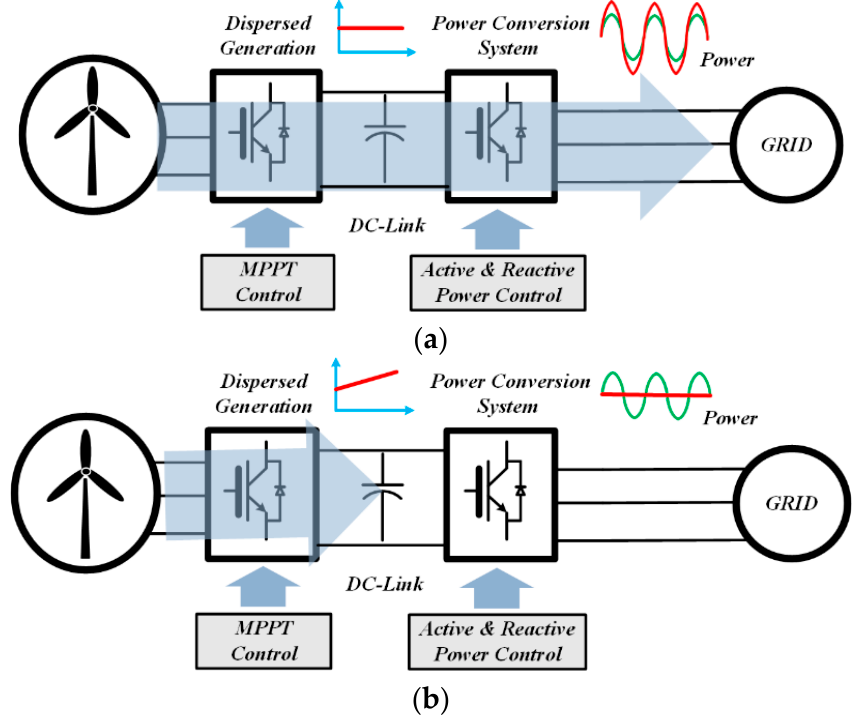
Figure 3. DC_link voltage fluctuation in each situation: ( a ) steady condition; ( b ) LVRT condition.